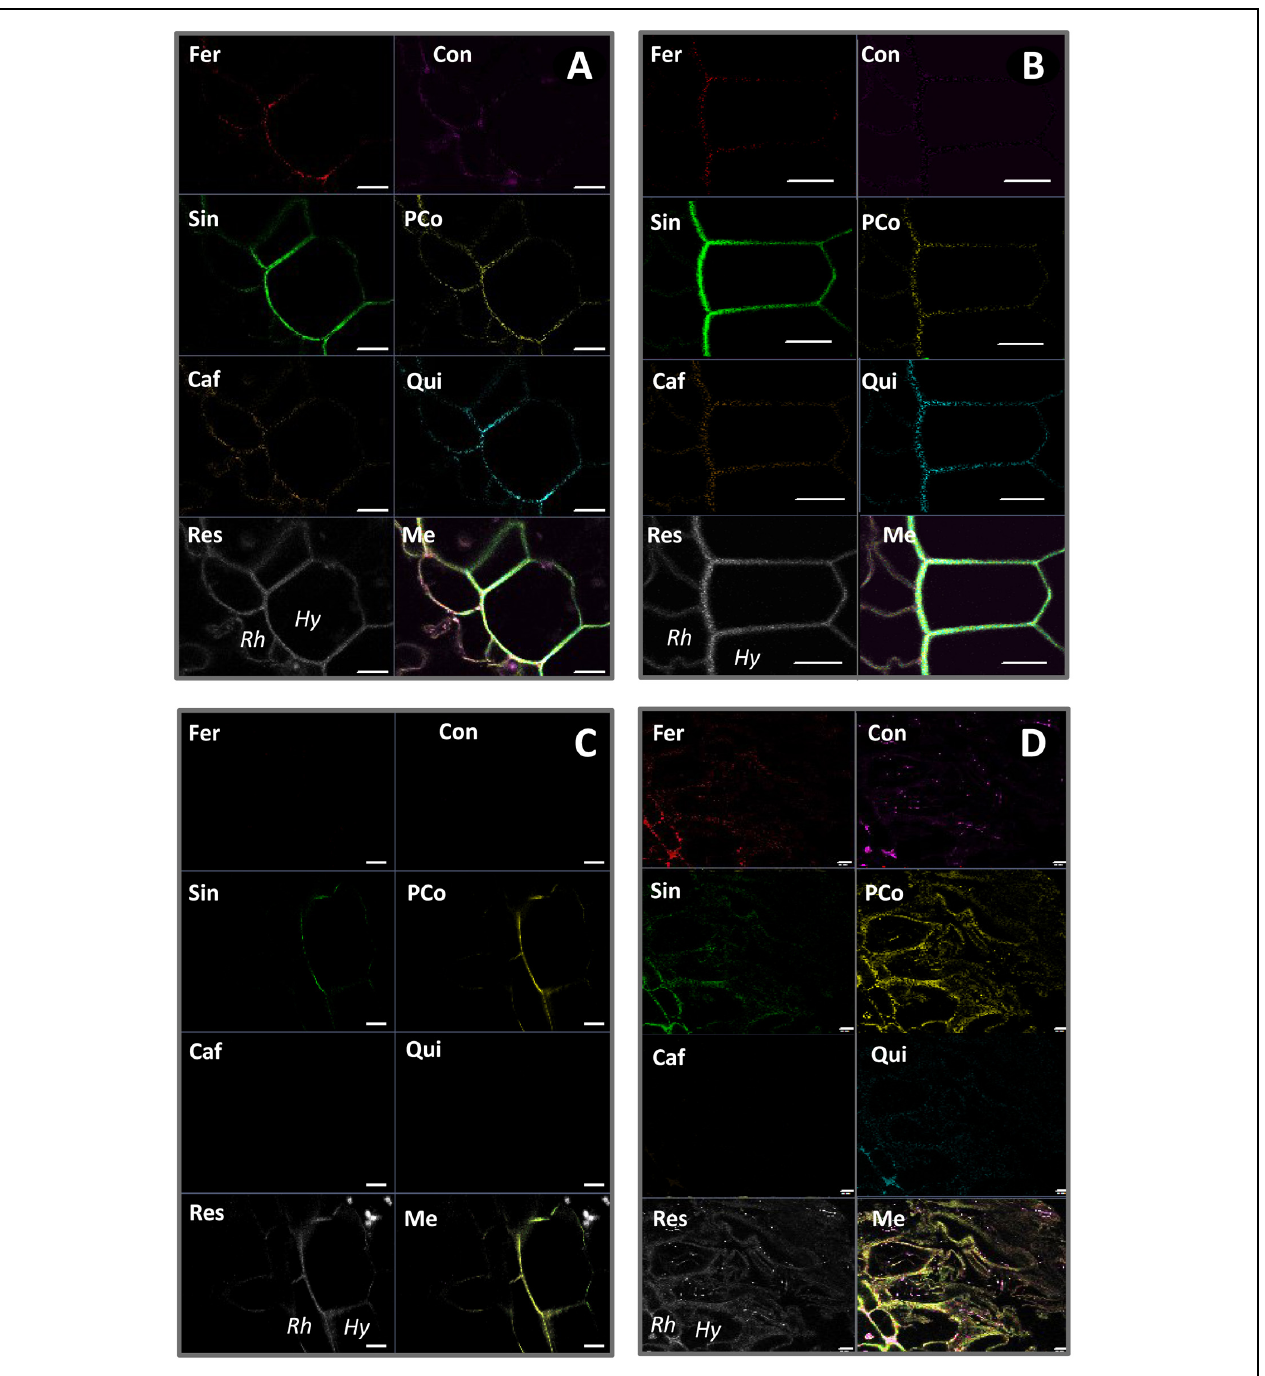
FIGURE 9 | Spectral unmixing analyses of non-inoculated roots of pla0001 (A) and pom0018 (B), and Fo072 inoculated root sections of pla0001 (C) and pom0018 (D) accessions, using six reference emission spectra compounds : Fer = ferulic acid; Con = conyferylic acid; Sin = sinapinic acid; pCo = p-coumaric acid; Caf = caffeic acid; Qui = quinic acid. Res = residual channel and Me = merged image. Rh: rhizodermis, Hy: hypodermis. Scale bar: 20 μ